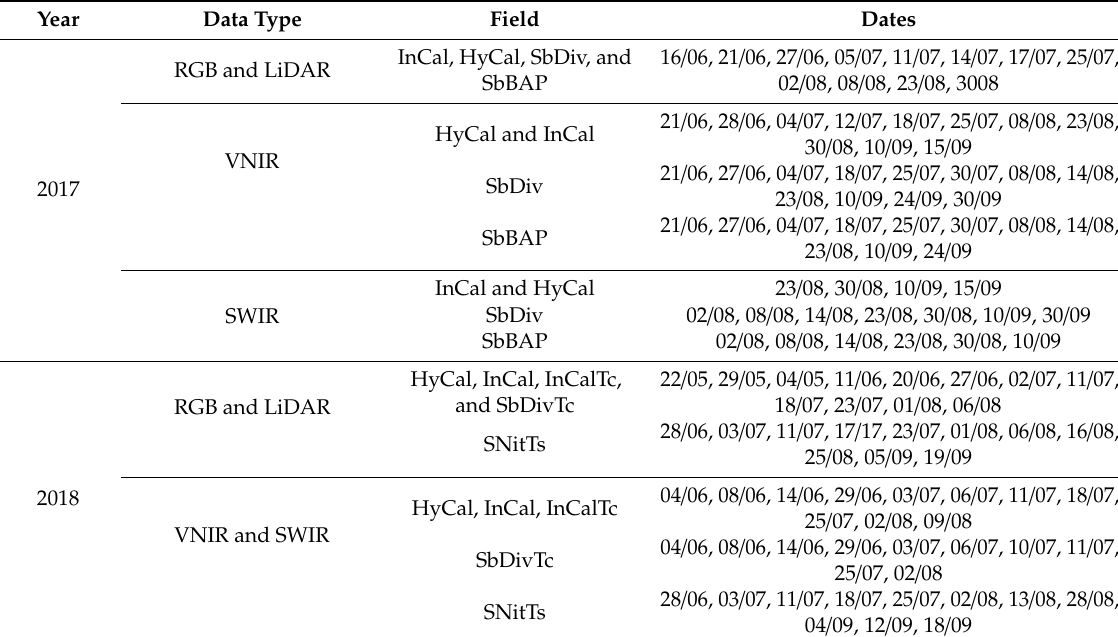
Table A2. Remote Sensing Data